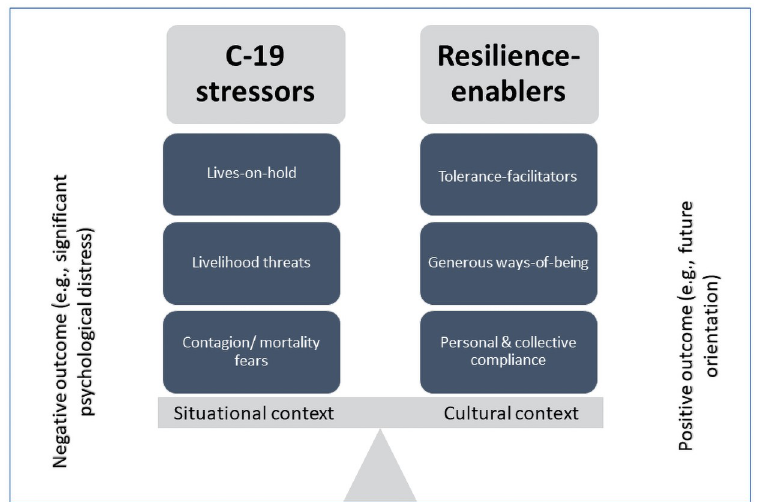
Fig 2. Summary of findings. Management of COVID-19-related stressors (that were strongly informed by the structurally disadvantaged context of eMba township) was supported by resilience-enablers (that were strongly informed by traditional African values that promote interdependence and tolerance). To tip the balance board in favour of positive outcomes would require redress of the structural drivers of the COVID-19 stressors that were prominent in participant